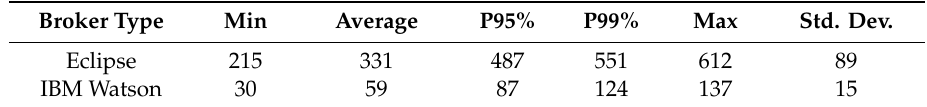
Table 5. Statistics of the L PS (Latency between Publisher and Subscriber without passing in the database) collected in the experiments. All values are in milliseconds.